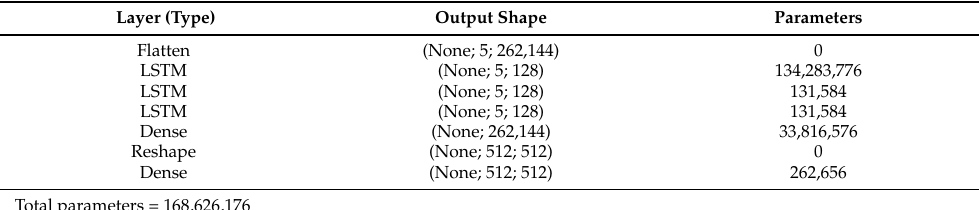
Table 11. Description of the Stack-LSTM network